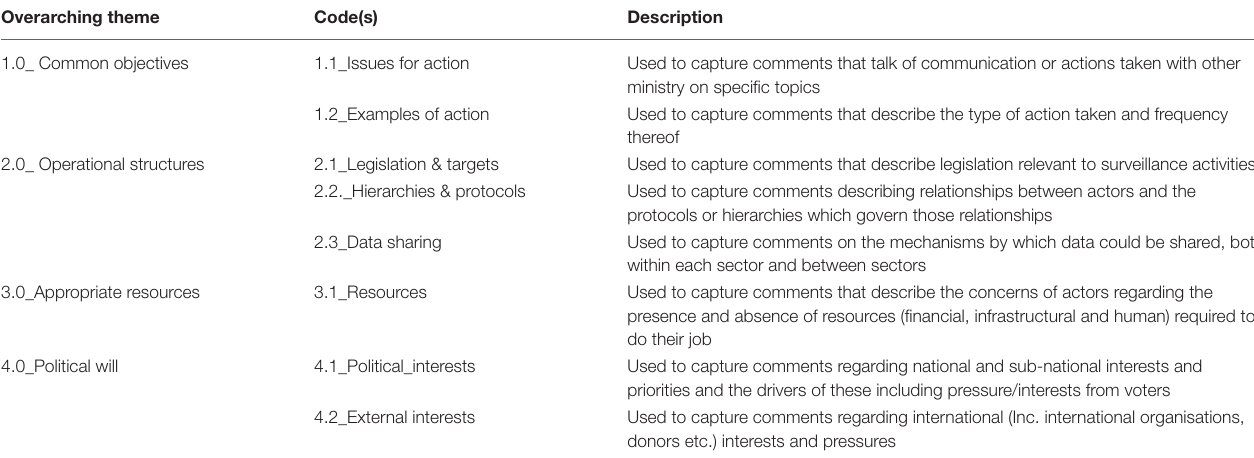
TABLE 2 | Code Book describing codes emerging from the transcripts and the themes under which they were grouped. Overarching